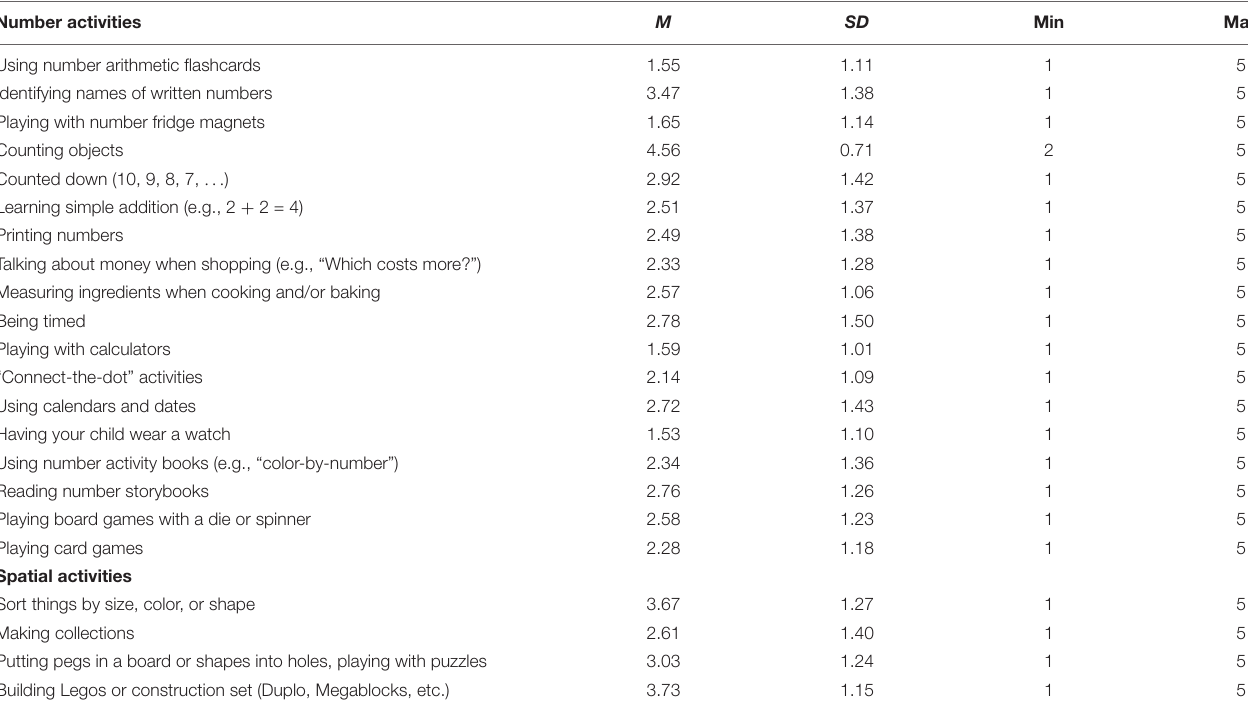
TABLE 1 | Item-level descriptive statistics for number and spatial activities at